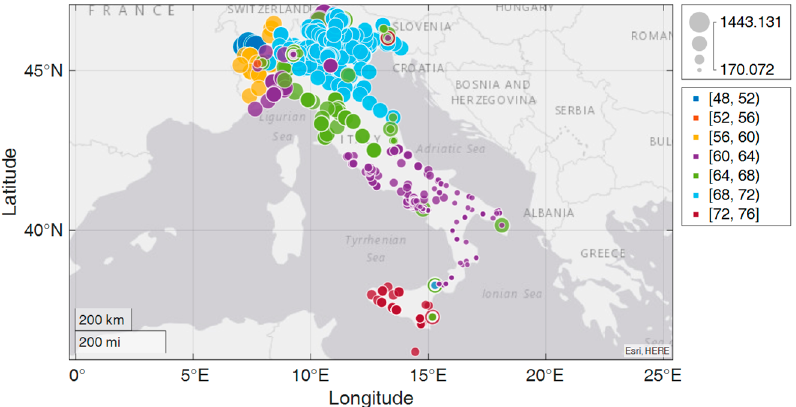
Figure 4. The colour and the size of the bubbles represent the mean value and the variance of the LMP of a node, respectively.